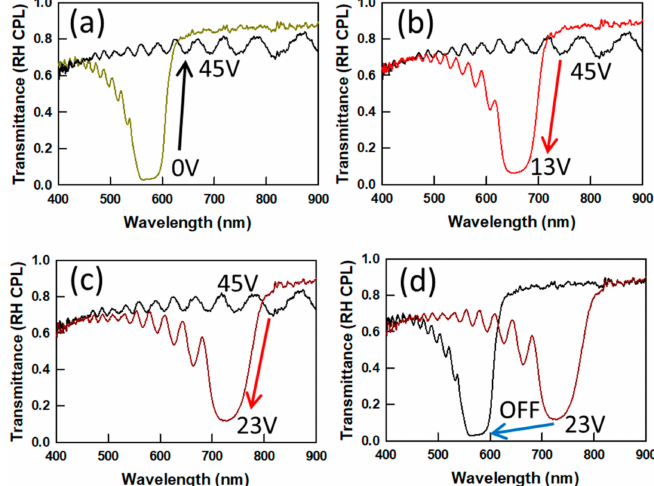
Figure 5. Transmission spectra of a ∆ ε < 0PSCLC with 5 ± 0.2 µ m thickness showing a ( a ) reflective to transparent or ( b , c ) transparent to reflective switching response by application of a DC voltage. ( d ) Spectra for the relaxation to the o ff state from 23 V.